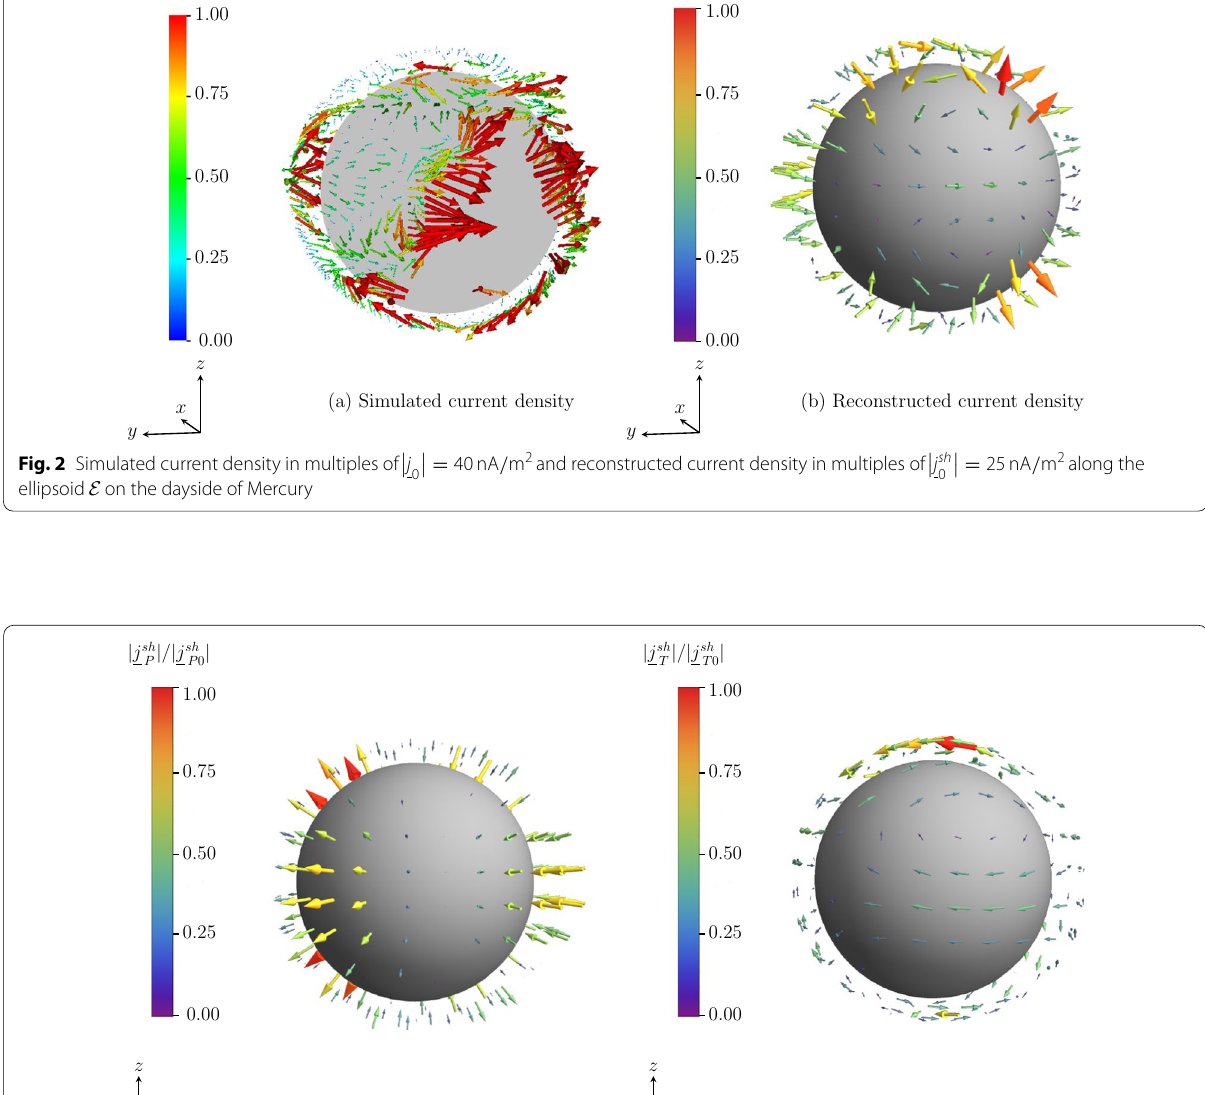
(a) Poloidal current density j sh